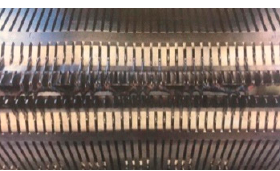
Figure 2. Knitting machine setup to